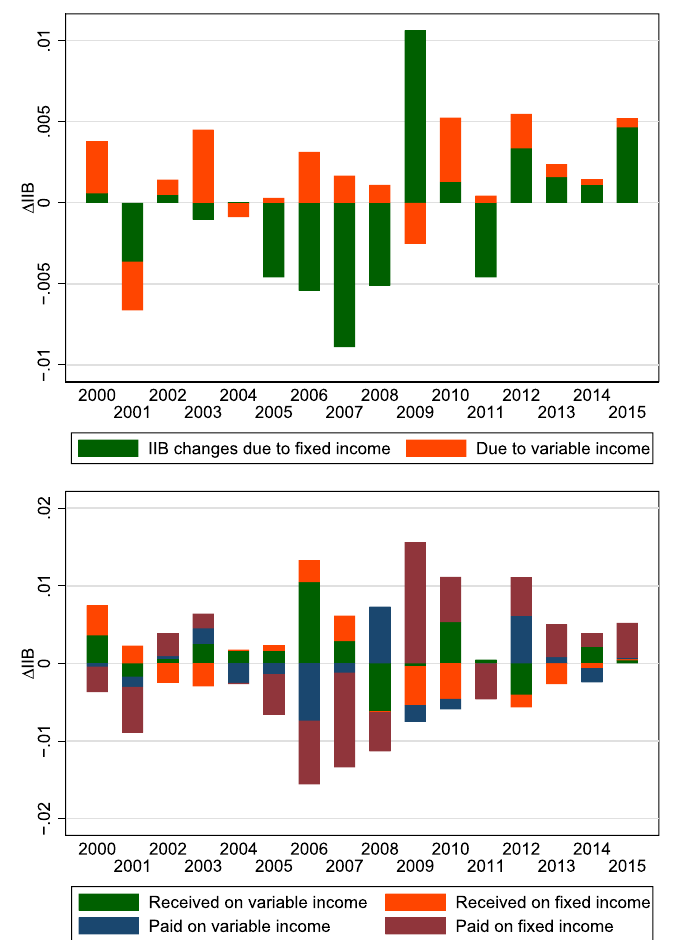
Fig. 7 Accounting decomposition of the investment income balance. Notes. The left panel shows changes in the investment balance distinguishing by net payments received on the stock of equity (FDI and portfolio equity) and net payments received on debt assets. The right panel further decomposes payments into those made to international investors and those received from